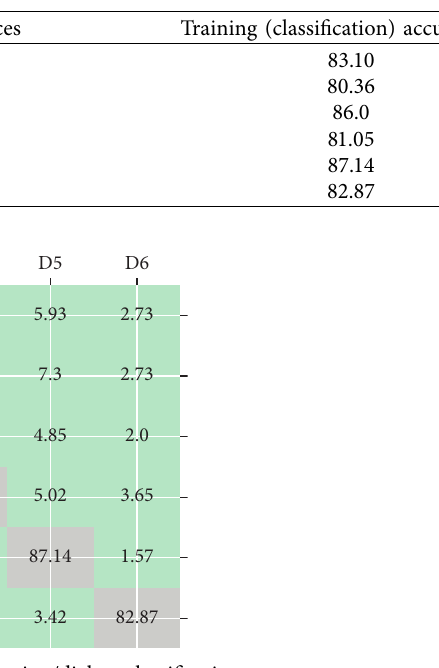
Table 5: Training accuracies of the selected dialects.